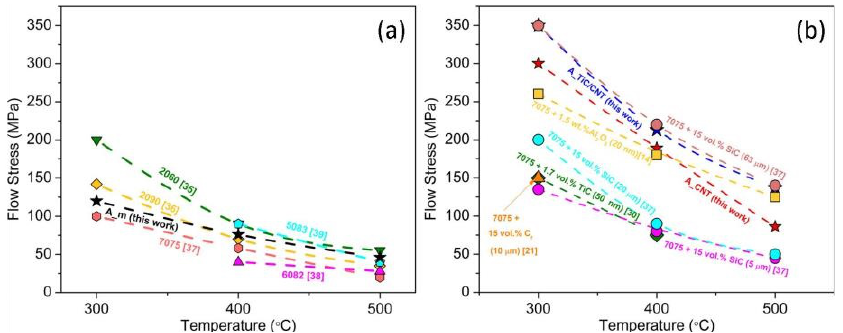
Figure 6. Flow stress of aluminum alloys ( a ) and composites based on them ( b ) at temperature 300 – 500 °C and strain rate 0.1 s −1 .